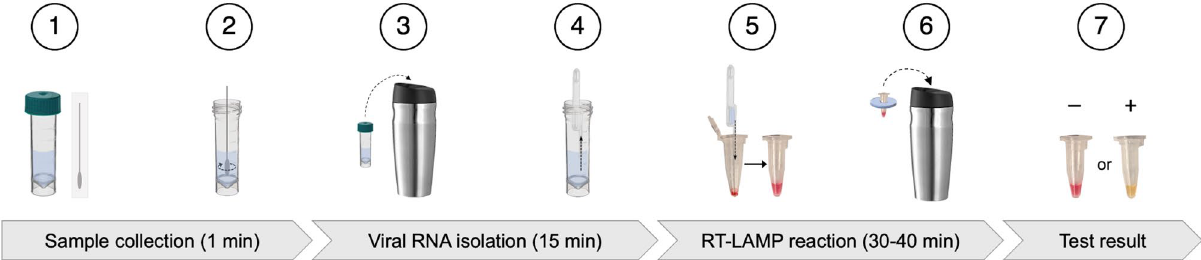
Figure 1. Schematic illustration of the COVID-19 home test from sample collection to test result readout. Step 1: Self-collect a sample using an anterior nasal swab (alternatively a gingival swab). Step 2: Plunge the swab into the media inside the collection tube. Gently rub and roll the swab against the tube wall for 10 times. Squeeze out the remaining liquid by pressing the swab against the side of the tube, discard the swab and recap the tube. Step 3: Add 95 °C hot water into a thermos. Ensuring the sample collection tube lid is tightly secured, place inside the thermos and close the lid, to incubate for 10 min. Step 4: Take out the collection tube and cool it on ice for 5 min, allowing any debris to settle to the bottom. Use a disposable transfer pipette to draw 20 μL of sample from the collection tube. Step 5: Quickly dispense the sample into the lyophilized RT-LAMP reaction tube. Recap and gently flick the side of the reaction tube to resuspend the mix (avoid introducing bubbles). Step 6: Use a thermometer or a temperature sticker (included in the kit) to adjust the water temperature to 65 °C in the thermos. Assemble the RT-LAMP reaction tube onto the foam floater and place it in the thermos. Close the lid and incubate for 40 min. Step 7: Take out the reaction tube and cool it on ice. Visually inspect the test result (pink = negative; yellow =